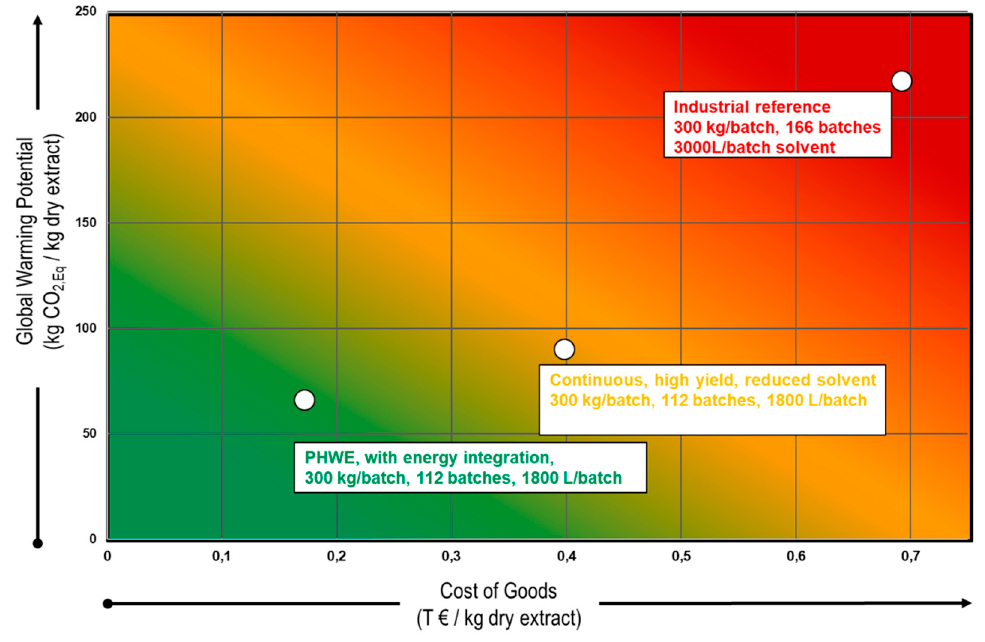
Figure 15. Botanicals global warming potential (GWP) vs. COGs portfolio.